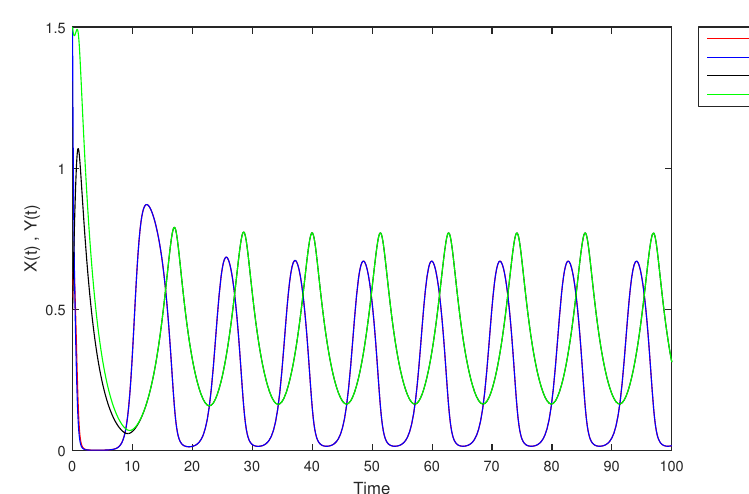
Figure 11. The solution of (7) at α = 0.0 as time increases. At α -level = 0.5, the solution is shown in Figures 12 and